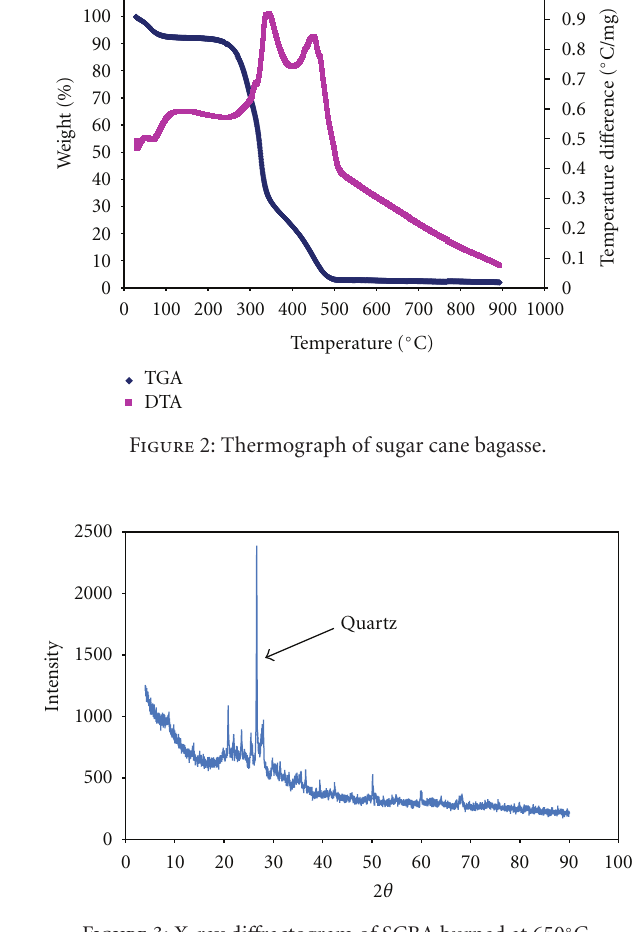
Figure 3: X-ray di ff ractogram of SCBA burned at 650 ◦